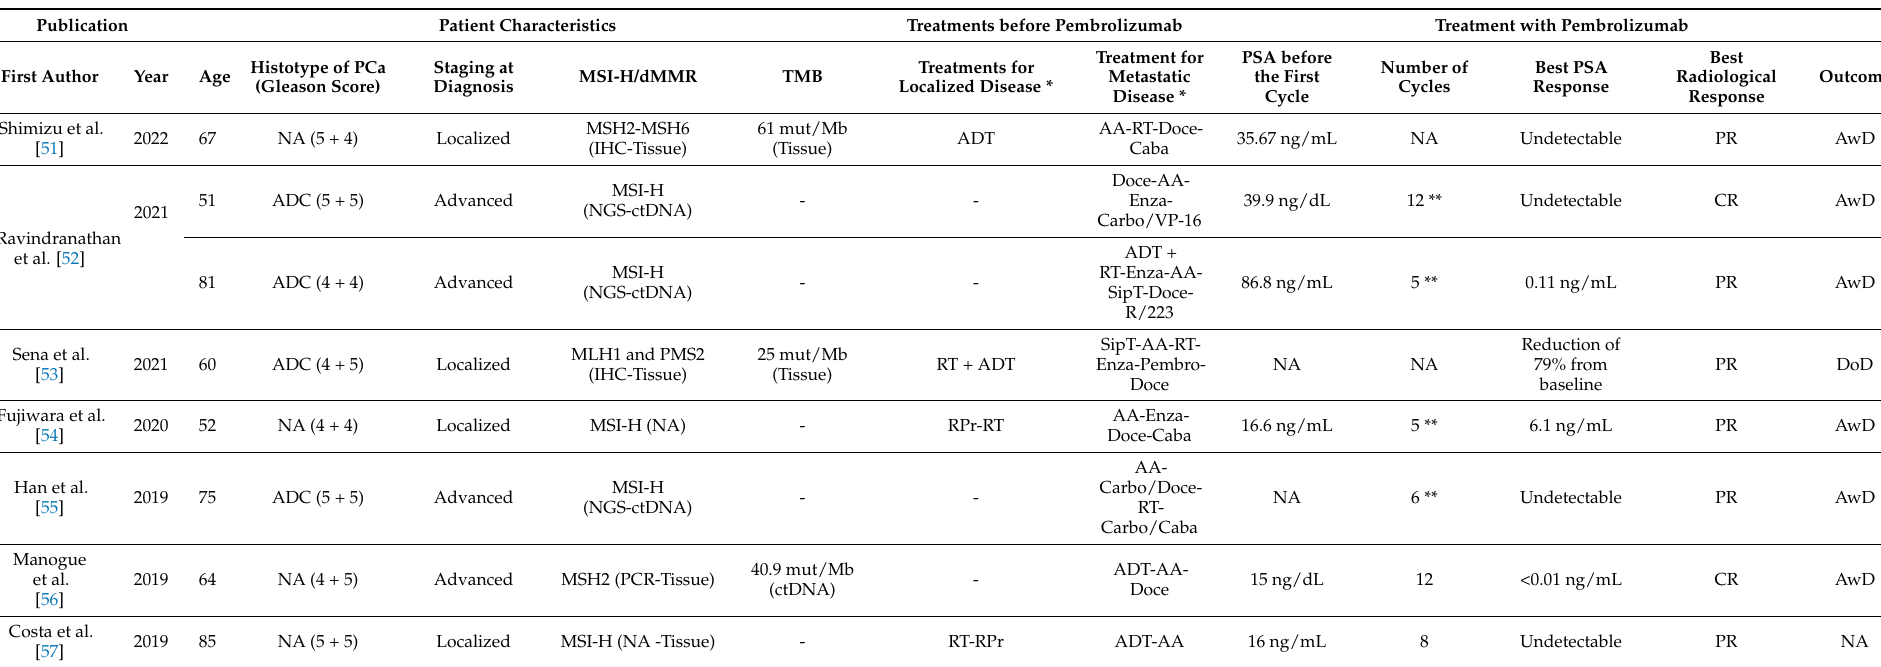
Table 2. List of case reports and case series on dMMR/MSH-H and TMB-H mCRPC patients treated with